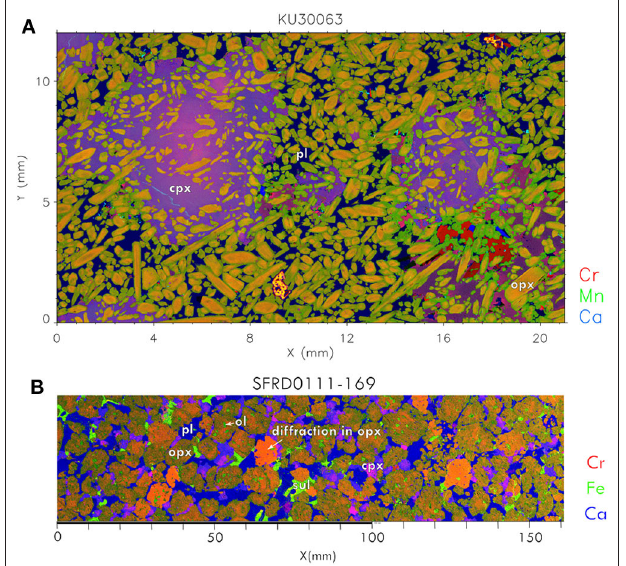
FIGURE 6 | (A) Large clinopyroxene (cpx) oikocrysts enclosing small orthopyroxene (opx) chadacrysts and surrounded by orthopyroxene in the Rytky intrusion from the Kotalahti Nickel Belt. Sector zoning visible in the core of the large clinopyroxene with all grains displaying normal zonation of Cr. (B) Tornado XRF image, large sector zoned orthopyroxene cumulate oikocrysts containing small olivine chadacrysts. Sample SFRD0111-169 from the Nova intrusion. Sample shows the common feature of diffraction artifacts which is a known disadvantage of the desktop XRF mapping techniques. These artifacts give a false high Cr concentration for an entire grain that is due to the crystal orientation, displayed in the image as solid orange opx.